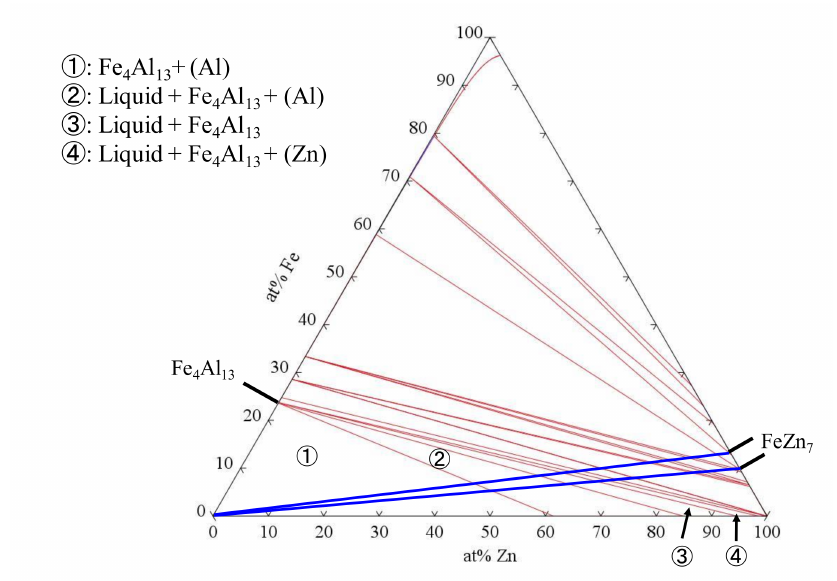
Figure 9. Isothermal section of the phase diagram of Fe–Zn–Al at 400 ◦ C calculated by Thermo- Calc